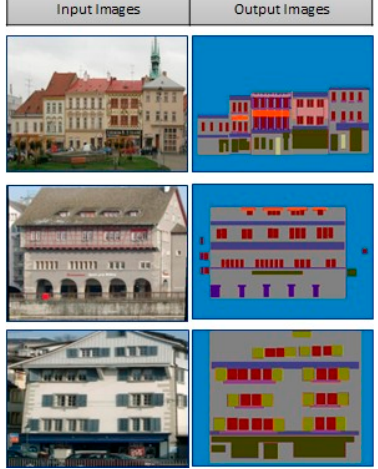
Figure 4. Automatic labeling using SegNet model.